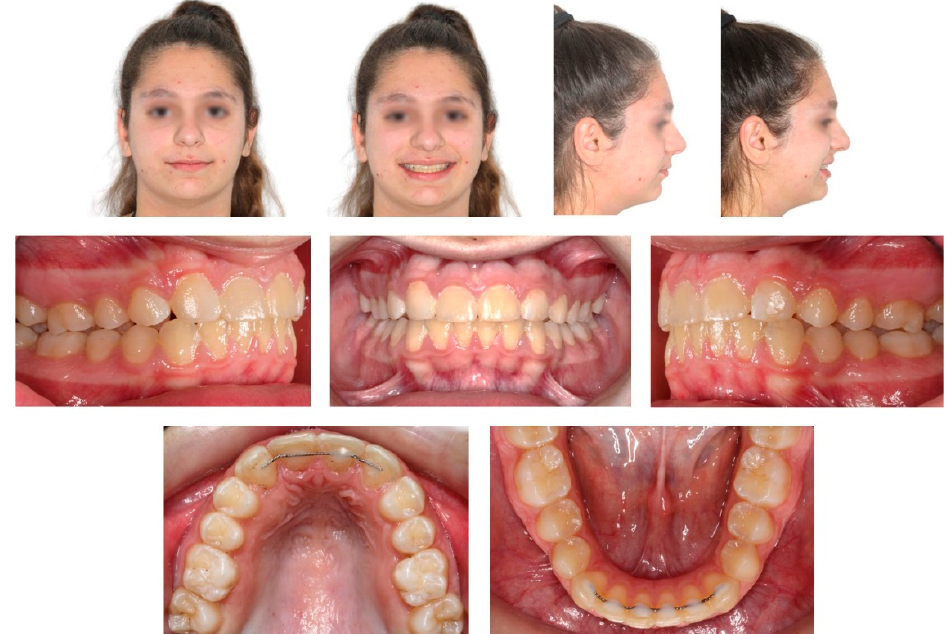
Figure 12. Extra- and intra-oral photographs at one-year post-debonding. Treatment results remained stable.